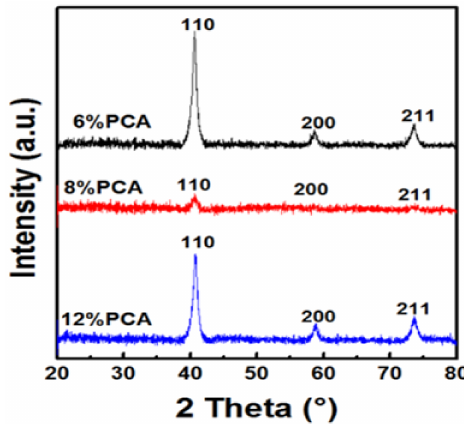
Figure 9. The XRD pattern of tungsten powder ball-milled for 60 h with different additive amounts of